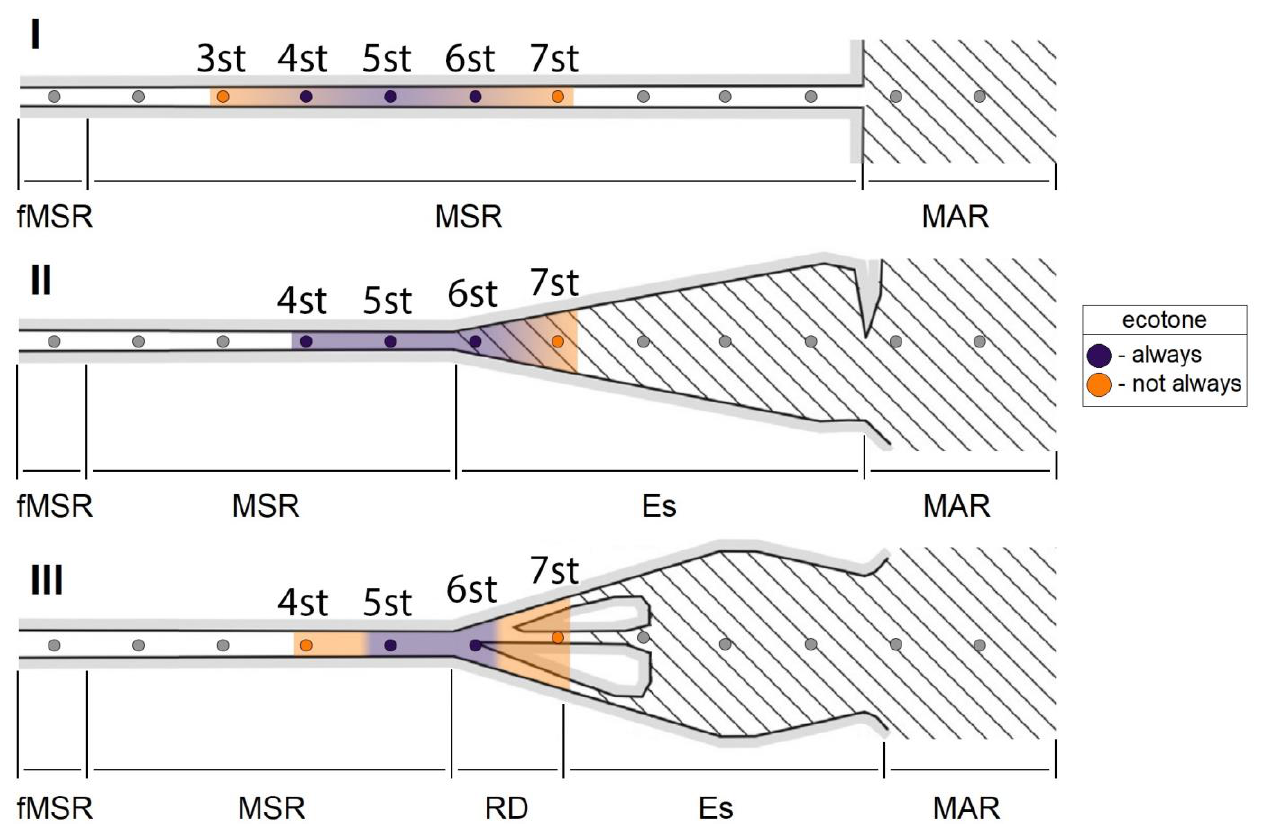
Figure 4. Location of the ecotone (community 2) in different types of mouth areas in the studied tributaries. The mixing zone of water masses of the river and the reservoir is highlighted with a shading line. The scheme is based on that of V.N. Mikhailov et al. [34]. Always—stations in which all (not all) rivers were part of the ecotone (community 2); not always—stations in which not all rivers were part of the ecotone (community 2). ( I ) — simple mouth area; ( II ) — estuarine mouth area; ( III ) — estuary – deltaic mouth areas. The names of the zones are shown in Figure 1.